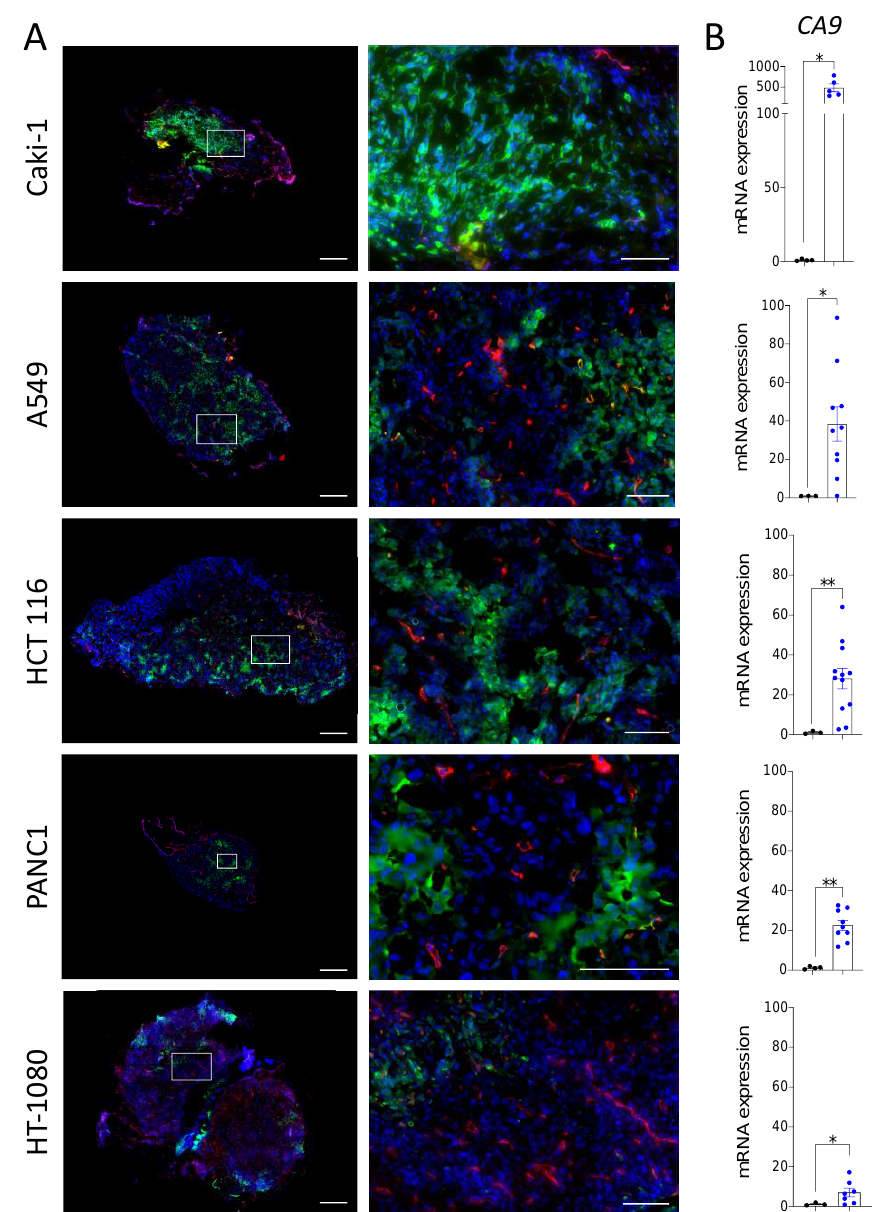
Figure 1. ( A , B ) HT-1080, HCT 116, A549, PANC-1, or Caki-1 cancer cell lines were inoculated onto ChorioAllantoic Membrane (CAM) and grown for 7 days. A mix of Lens culinaris agglutinin (LCA) (0.05 mg/CAM) and pimonidazole (1.5 mg/CAM) was injected into CAM vasculature prior to tumor xenograft extraction from the CAM. ( A ) Representative immunofluorescence images and corresponding zooms showing regions of hypoxia (pimonidazole; green) and vascularization (LCA; red) in tumor xenografts. Nuclei were stained with DAPI (blue). Scale bar = 500 µm. Zoomed area is outlined in white, scale bar = 100 µm. ( B ) qPCR analysis of mRNA isolated from HT-1080, HCT 116, A549, PANC-1, or Caki-1 cell lines in 2D culture or xenografts grown on CAM. Results are expressed as relative mRNA expression of CA9 (CAIX) in tumor xenografts (blue dots) compared to corresponding cell lines in culture (black dots). RPLP0 was used to normalize the data. (cell lines in 2D culture n = 3, cell line-derived xenografts n = 6 – 13). Bars represent the mean ± SEM. The asterisks (*) correspond to p < 0.05 (*) and p < 0.01 (**), non-parametric t test.